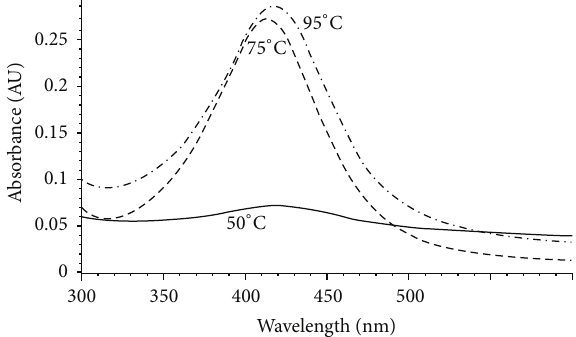
Figure 7: UV-vis absorption spectra chitosan-Ag nanoparticle materials synthesized with 0.02 M AgNO 3 at 50 ∘ C, 75 ∘ C, and 95 ∘